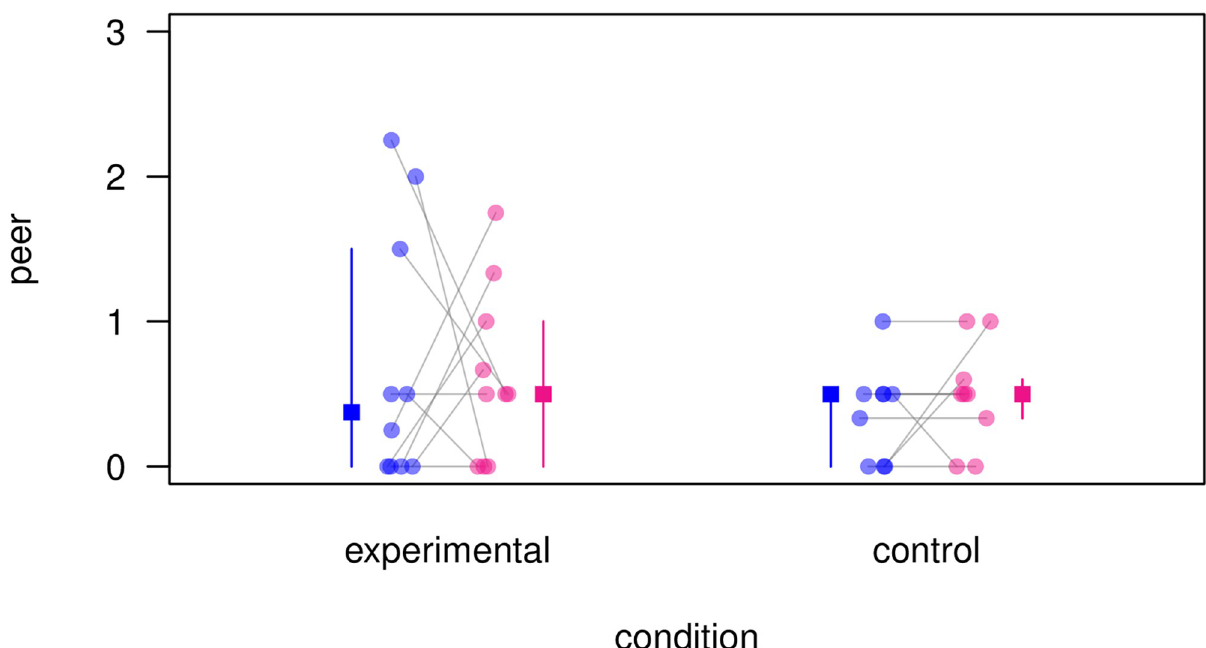
Fig 3. Peering frequency. Mean frequency of peering across individuals at the blue and pink food troughs in test and control trials. Circles represent mean frequencies of peering across individuals (10 subjects participated in the 6 test trials and 9 subjects participated in the 6 control trials). Squares with bars represent medians with 25% and 75% quartiles. Subjects in the test condition show higher bias for one of the two troughs than subjects in the control condition.